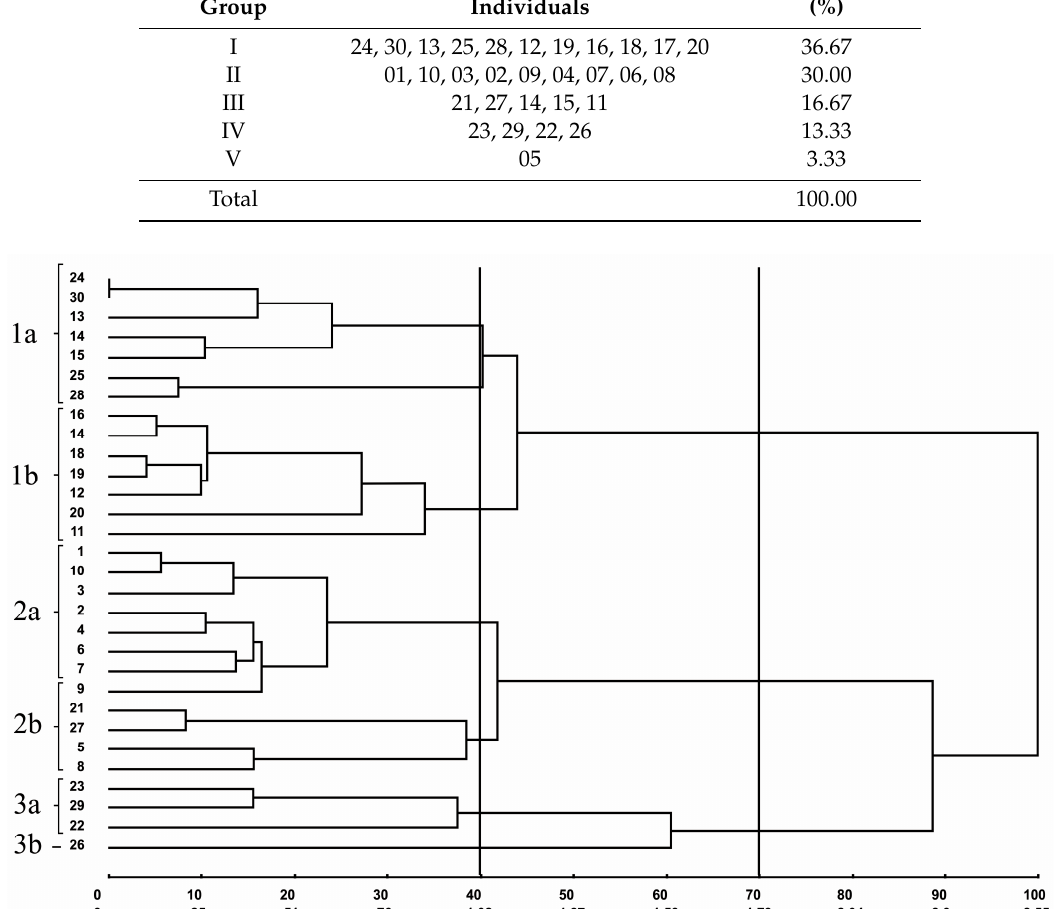
Figure1. Dendrogramrepresentingthedissimilaritypatternamongthe30buriti( M.flexuosa Figure 1 Dendrogram representing the dissimilarity pattern among the 30 buriti ( M. flexuosa ) individuals obtained through the unweighted pair group method, the arithmetic mean (UPGMA) was based on the standardized Euclidean distance estimated from 14 quantitative traits of the buriti fruits and seeds.